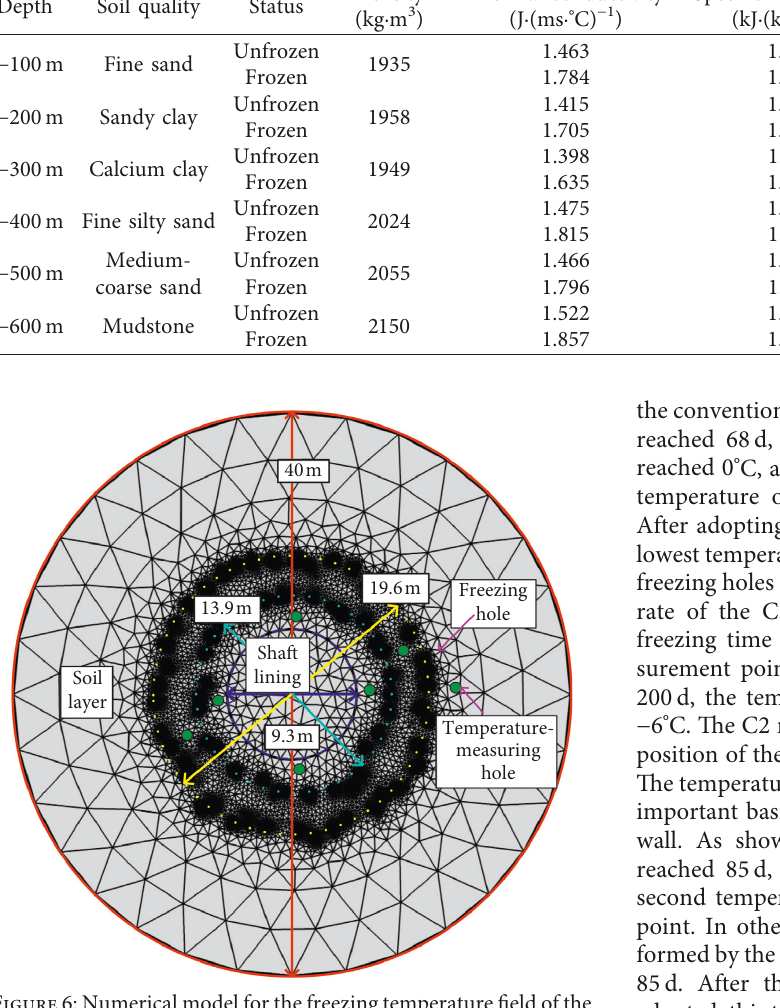
Figure 6: Numerical model for the freezing temperature field of the soil layer with a − 400m horizon.